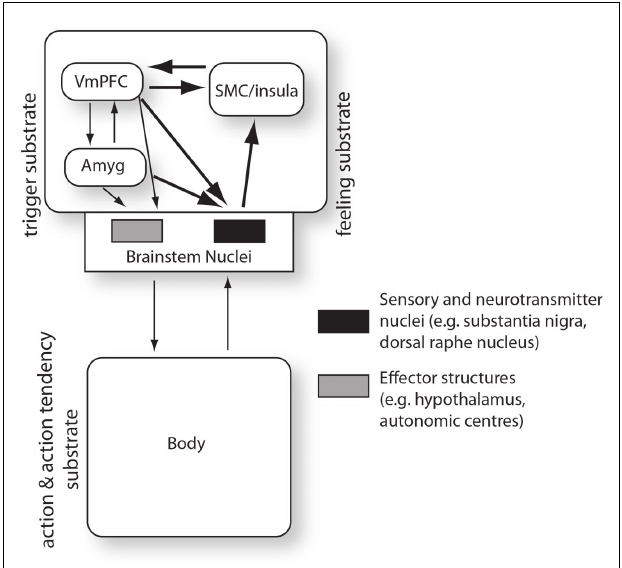
FIGURE 4 | Brain–body prediction–feedback loops: adaptation of Damasio’s brain–body loop theory of emotion and emotional feeling. The “as-if body loop” of Damasio is superimposed (thick arrows) on the “body loop.”The diagram can be seen to encapsulate at least two nested prediction–feedback regulatory loops implemented byVmPFC and Amyg projections: firstly, the brain-stem nuclei are provided a coarse predictive representation of body state; secondly, the SMC/insula is provided a more contextual predictive representation of body state as it relates to exteroceptive and proprioceptive late stages of processing in relation to the emotionally competent stimulus. Abbrev:VmPFC (ventral-medial prefrontal cortex), Amyg (amygdala), SMC (somatosensory cortices). Adapted from Lowe and Ziemke